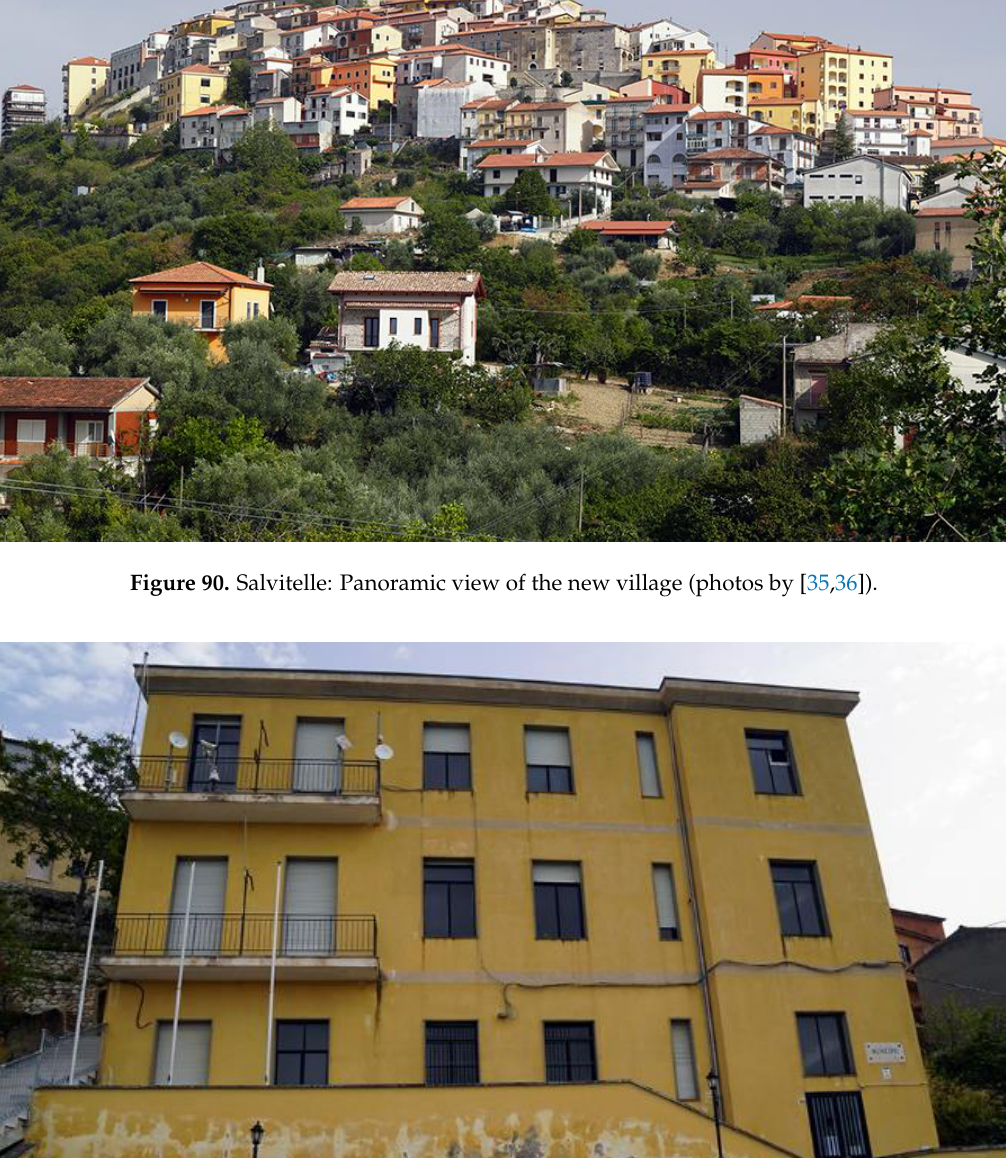
Figure 89. Romagnano al Monte: details of new buildings in the new town (photos by [35,36]).